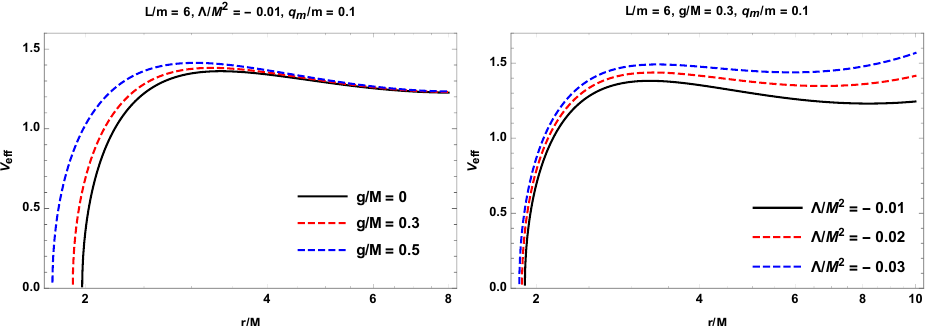
Figure 8. Effective potential of magnetically charged particle orbiting around regular Bardeen black hole in Anti-de Sitter spacetime.